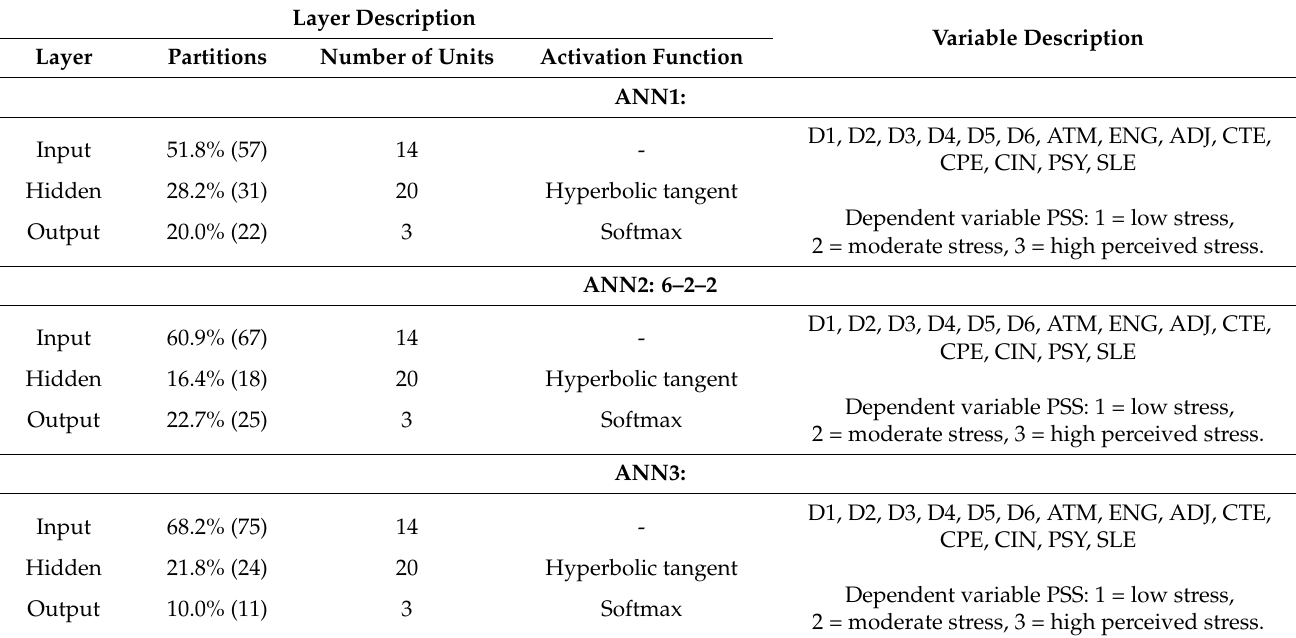
Table 4. Network information for case